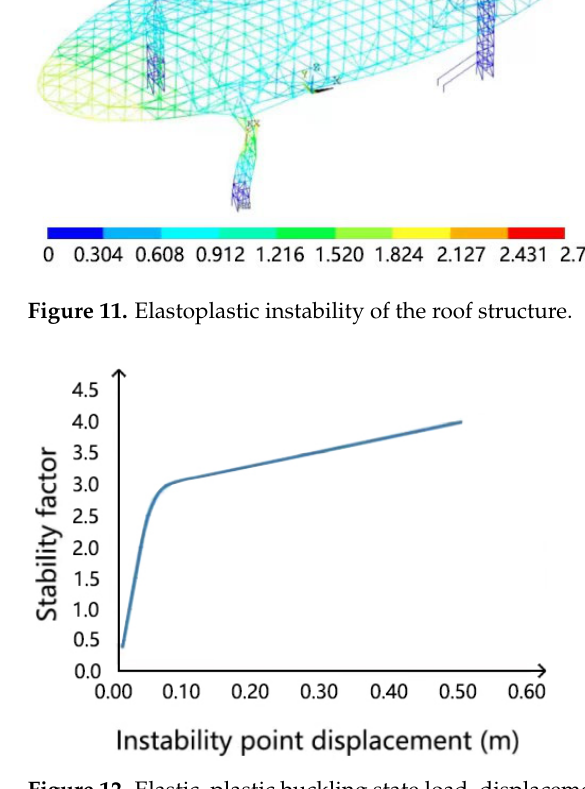
Figure 12. Elastic–plastic buckling state load–displacement curve.